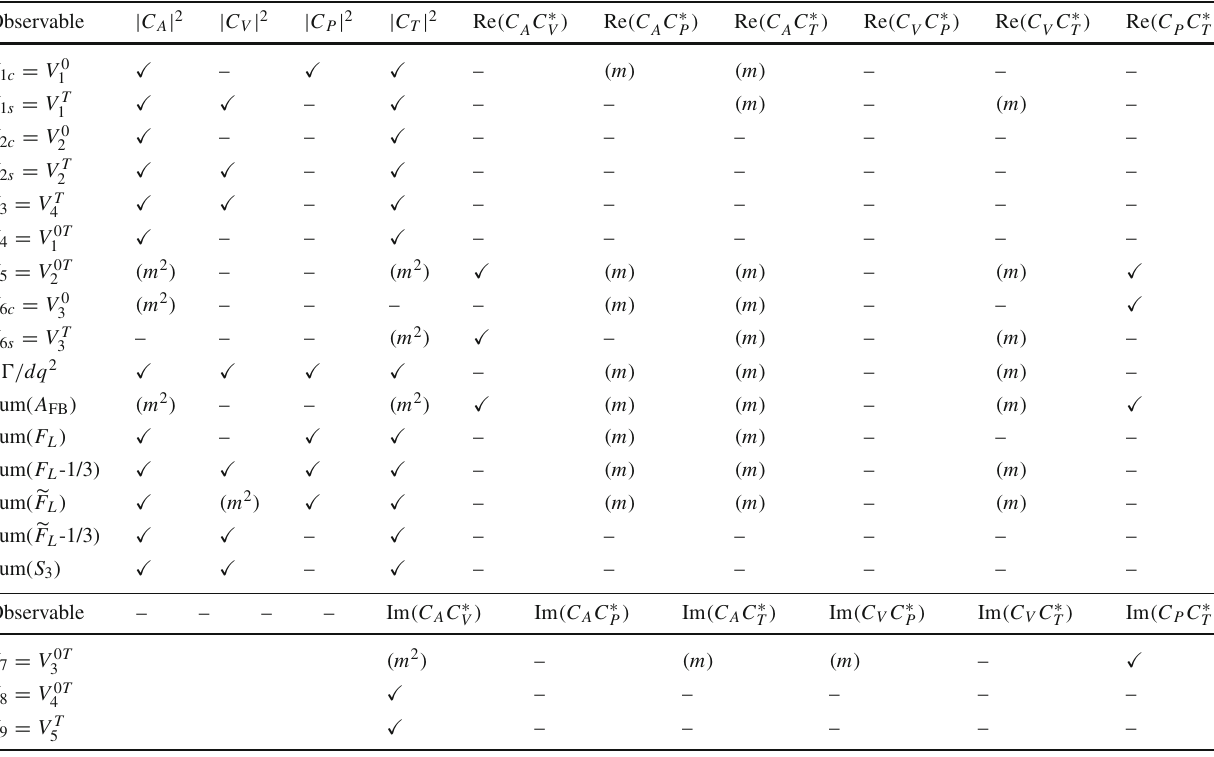
Table 1 The dependence of angular observables on combinations of Wilson coefficients. An entry of (cid:2) denotes the presence of this combination. An entry of m n denotes the presence of this term, but with kinematic lepton-mass suppression ∝ ( m (cid:2) / that only the dependence of the numerator of this observable is given. The V a